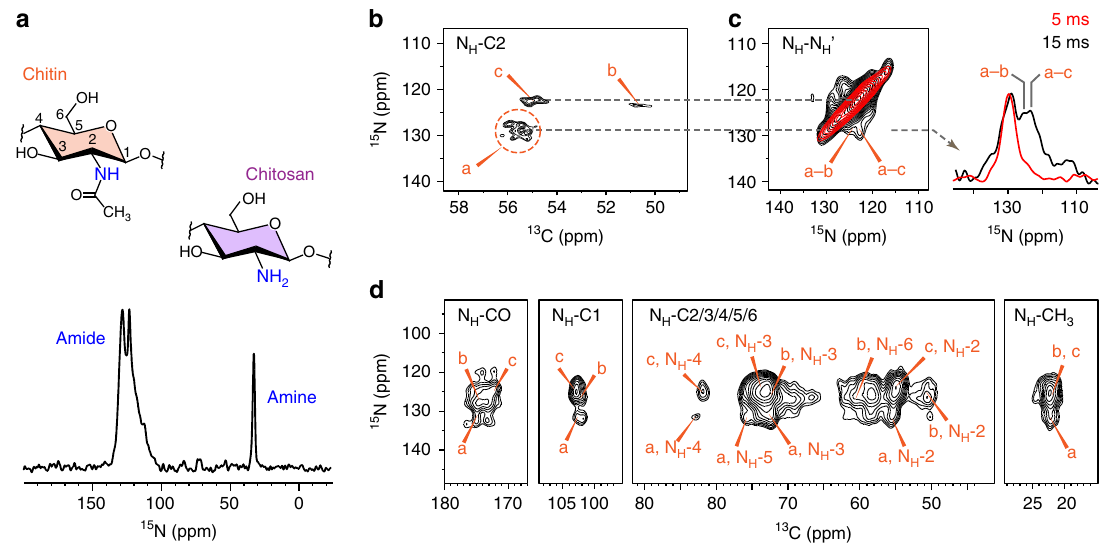
Fig. 2 Chitin is structurally polymorphic in intact A. fumigatus cell walls. a 1D 15 N spectrum resolved multiple amide and amine signals. b High-resolution 15 N – 13 C correlations spectra resolved three major types of chitins. c DNP-assisted 15 N – 15 N PAR spectra measured using 5 ms (red) and 15 ms (black) mixing times revealed extensive cross peaks between different chitin allomorphs. d DNP-assisted 15 N – 13 C correlation spectra measured using 3-mg A. Fungal polysaccharides are highly polymorphic in structure . The decent 13 C resolution of the A. fumigatus sample allows the unambiguous assignment of seven types of polysaccharides, including chitin, α -1,3-glucan, three types of β -glucans, mannan, and arabinan. In total 23 allomorphs have been identi fi ed for